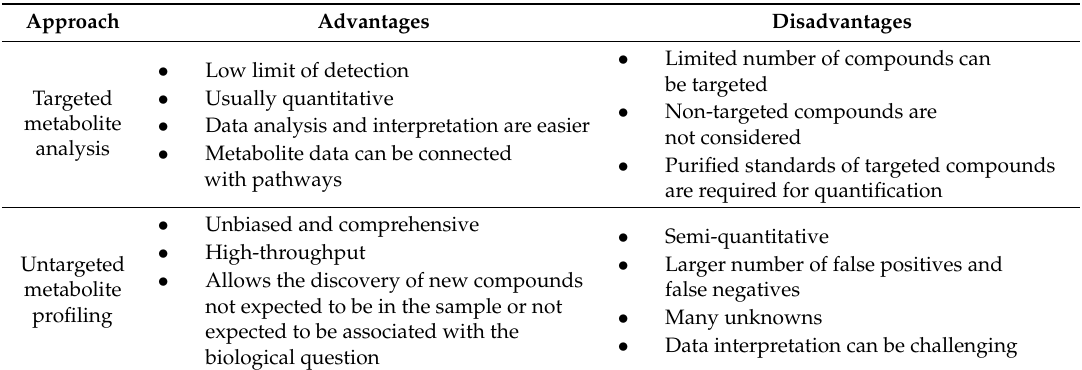
Table 1. Different approaches of metabolite